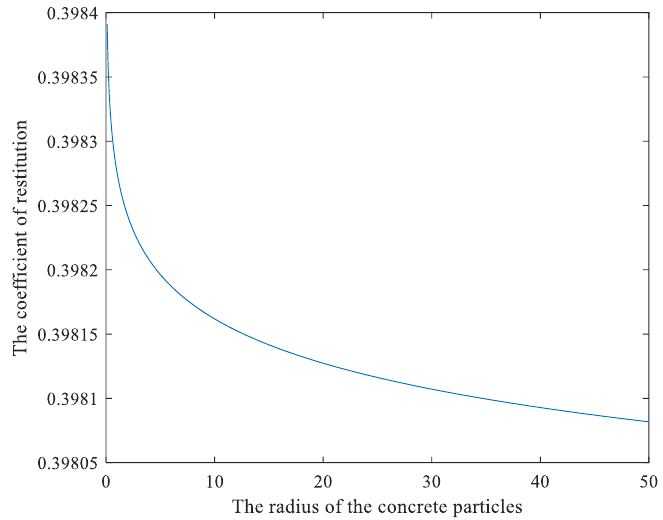
Figure 3. The relation between the particle radius and the coefficient of restitution.